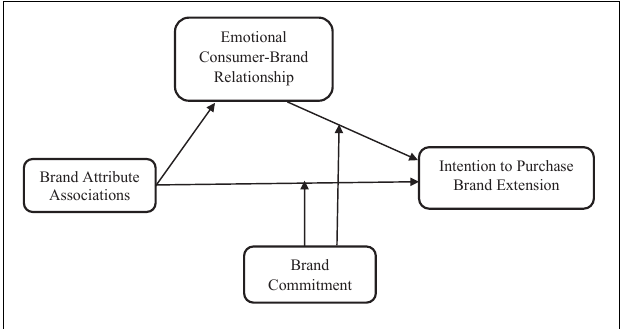
FIGURE 1 | Conceptual